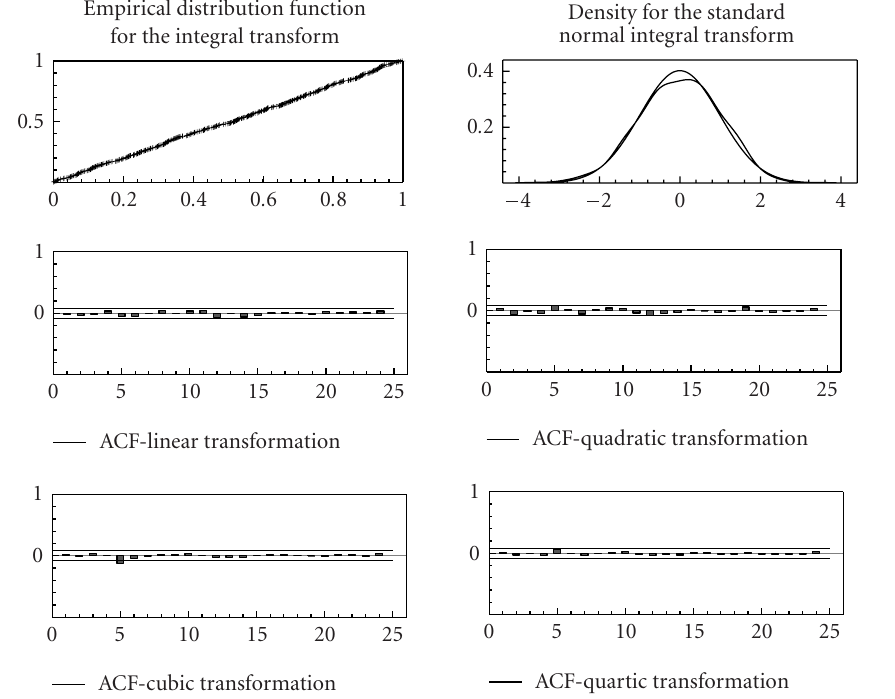
Figure 6.3. Density evalution and autocorrelation analysis for the simulated